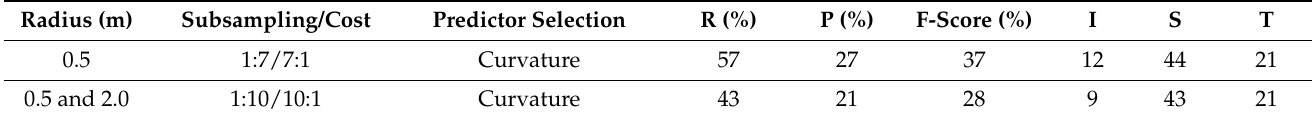
Table 5. Accuracy assessment with different performance scores for object-based